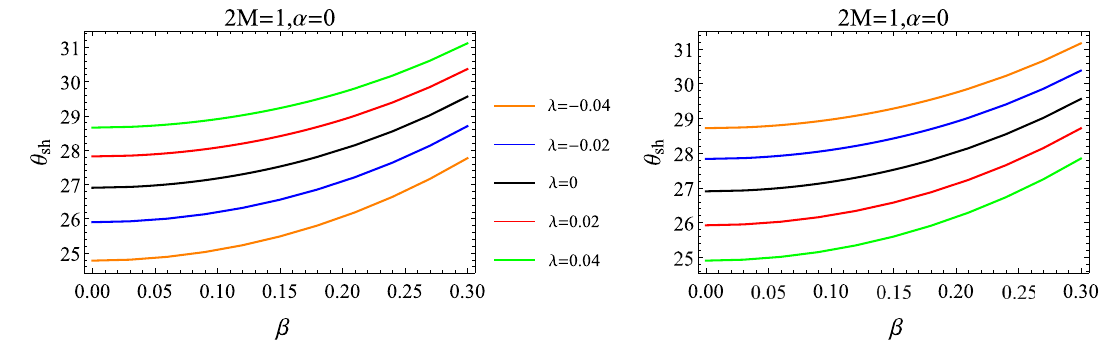
Fig. 4 Variation of the angular radius of the shadow with the X-cold dark matter parameter β in a Brane-World black hole spacetime. The left and the right are for PPL and PPR, respectively